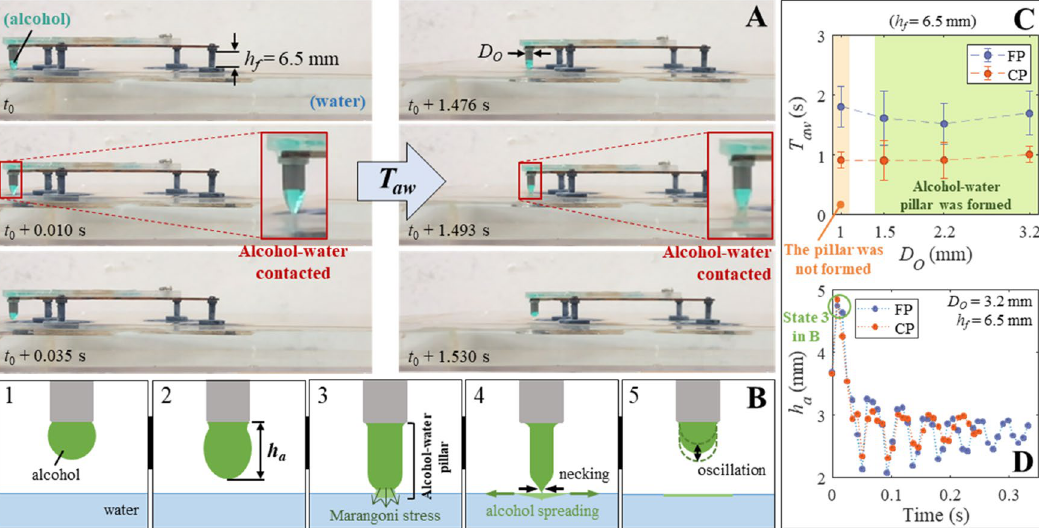
Figure 5. Incomplete droplet breakup at h f of 6.5 mm forms an alcohol–water pillar. ( A ) Premature alcohol– water contact at an h f = 6.5 mm ( t 0 : reference time, T aw : time between two episodes of alcohol–water contact). ( B ) A schematic of alcohol spreading at h f = 6.5 mm. ( C ) T aw versus D O ( n = 5). ( D ) Oscillation of alcohol column height ( h a ). Note that all the error bars denote standard